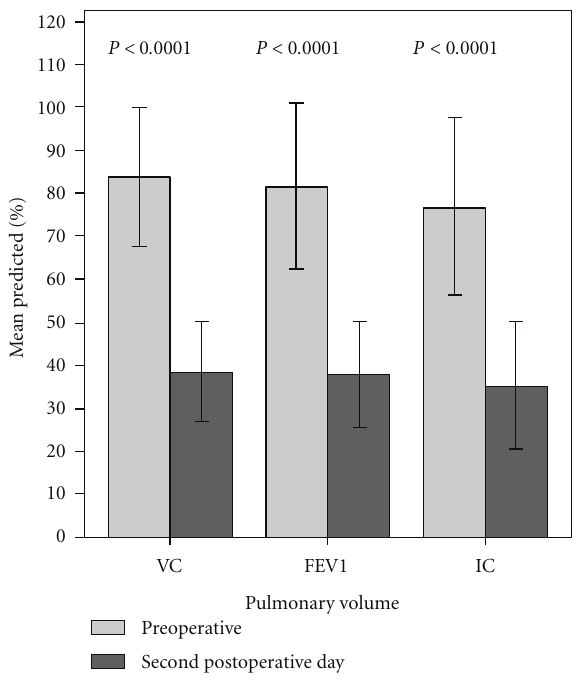
Figure 1: Lung volumes, percent of predicted values, preoperatively and on the second postoperative day, mean and SD, ( n = 107). VC: vital capacity, FEV 1 : forced expiratory volume in 1 second, and IC: inspiratory